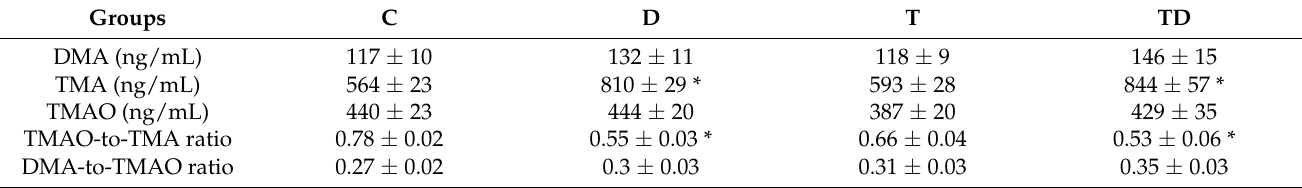
Table 3. Plasma trimethylamine (TMA), trimethylamine-N-oxide (TMAO), and dimethylamine (DMA) levels.